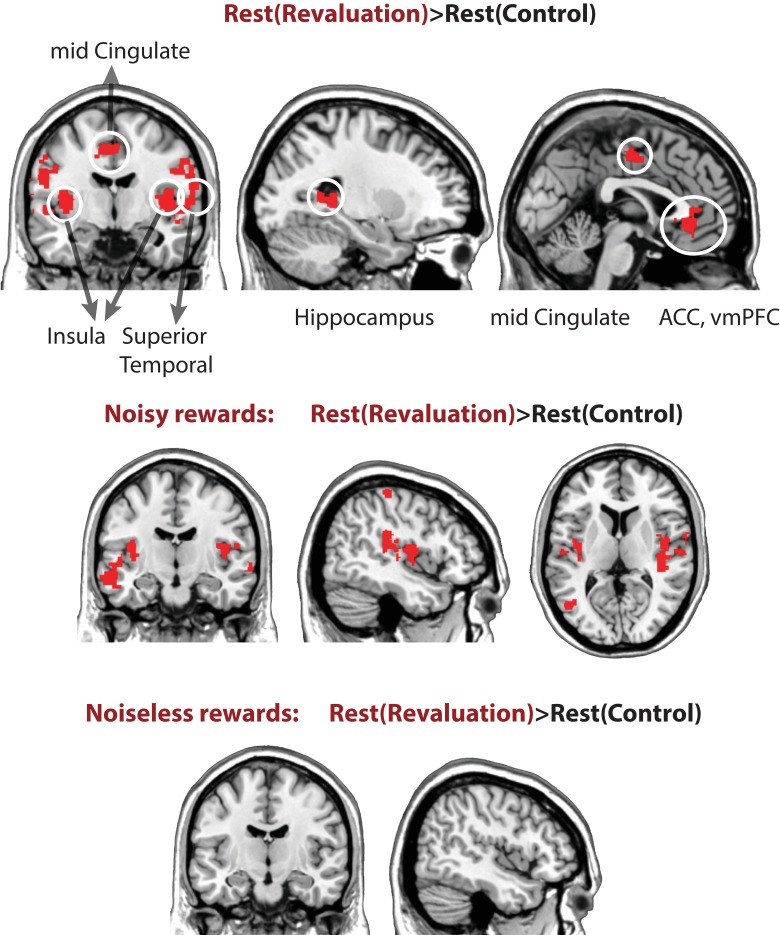
Differences in off-task univariate activation in revaluation vs. control.We compared the difference between univariate activation during the rest periods of control vs. revaluation blocks in all runs (top), in the noisy-rewards condition (middle), and the noiseless-rewards condition (bottom). The Rest(revaluation) > Rest(control) contrast in the noisy rewards conditions reveals lateral temporal cortices and the insula, whereas the noiseless condition did not reveal any significant regions (extent threshold p < 0.005, cluster FWE corrected, p < 0.05).